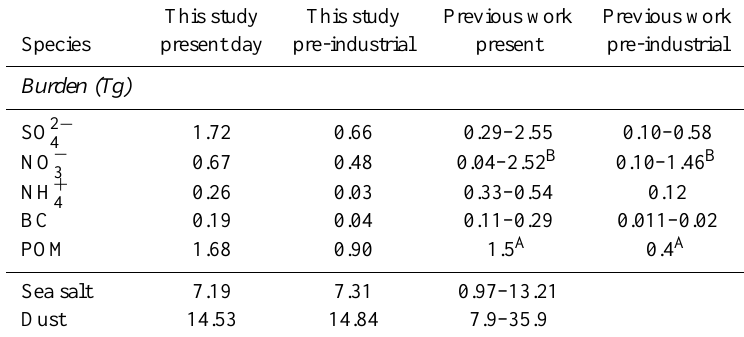
Table 4. Simulated aerosol burden in present day and pre-industrial conditions. Dust and sea salt emissions are identical in the present day and pre-industrial simulation. The review of previous works is taken from Tsigaridis et al. (2006), except for: A Stier et al. (2005) and B Bauer et al. (2007). POM=Particulate organic matter, BC=black carbon. All units are Tg. This study This study Previous work Previous work Species present day pre-industrial